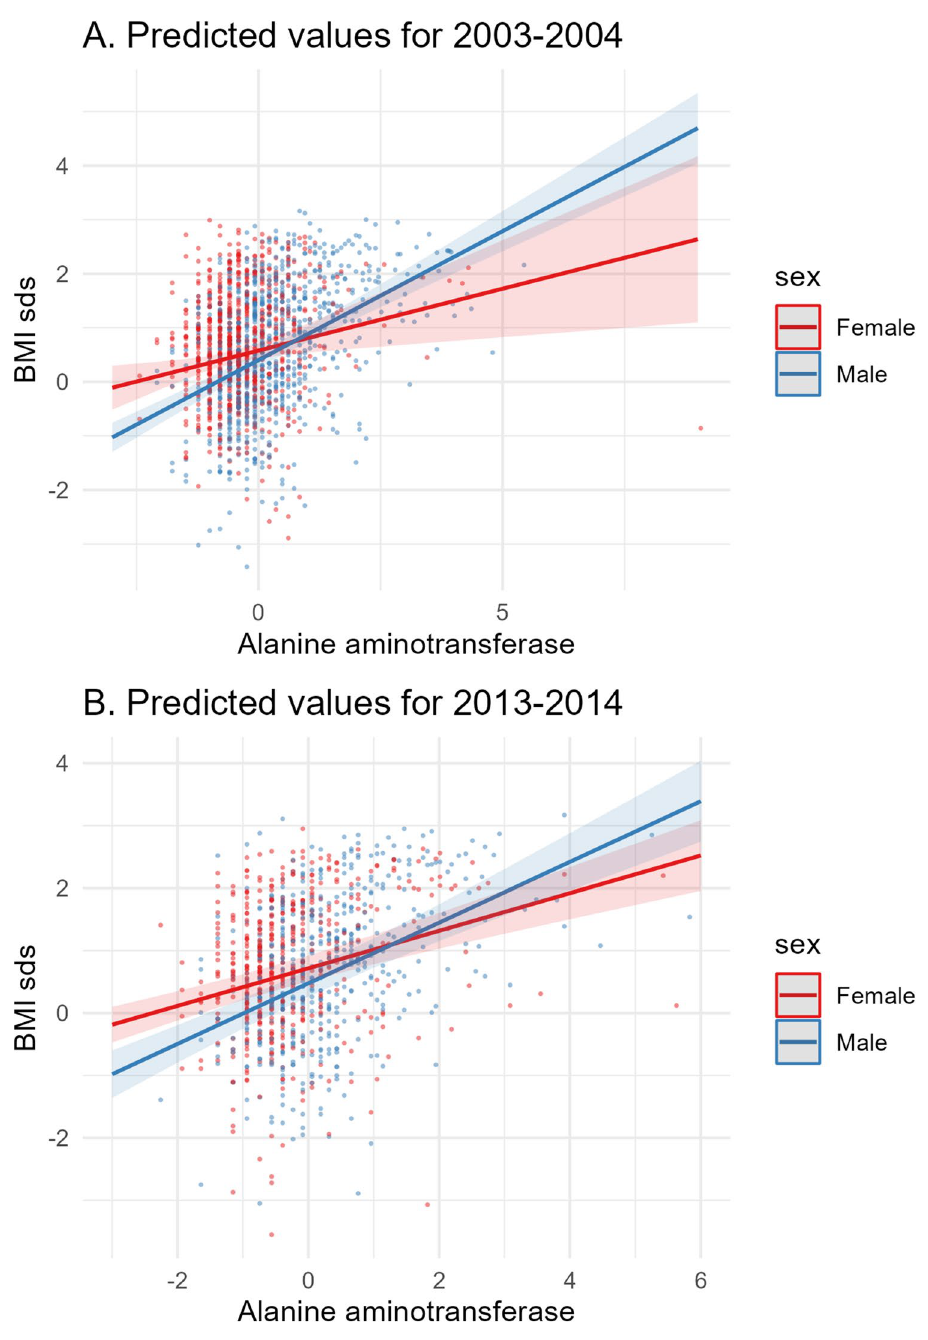
Figure 6. Scatter plots of the zBMI and alanine aminotransferase in the 2003–2004 and the 2013–2014 survey datasets including the line of the predicted values from the multivariable regression models that include the interaction